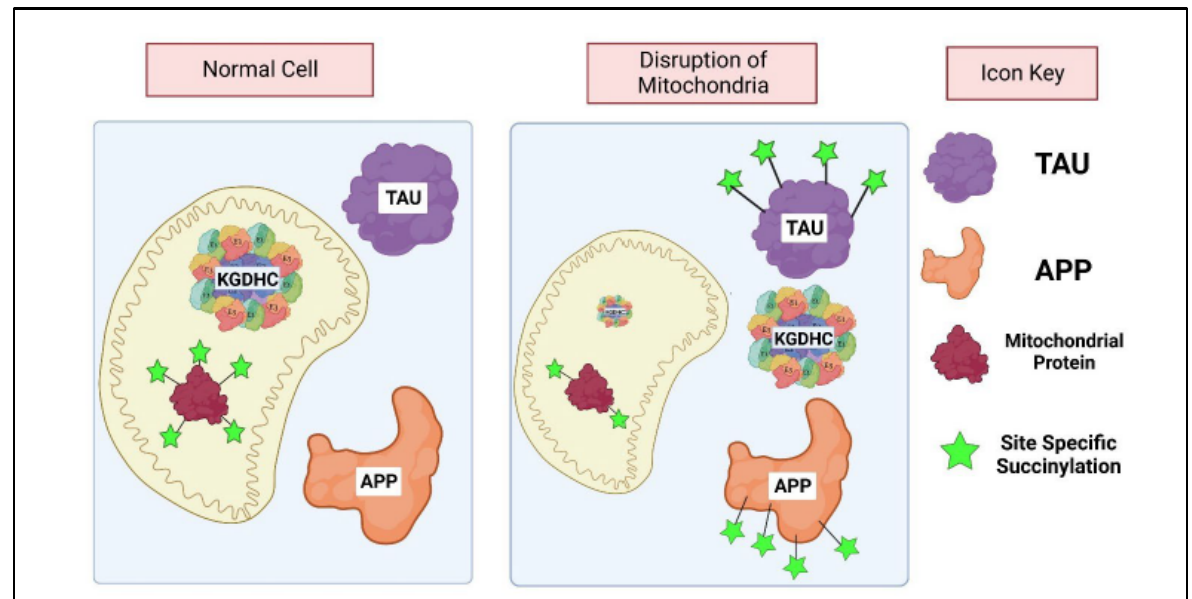
Figure 8. α -ketoglutarate dehydrogenase (KGDHC) and signaling by post translational modification through succinylation. In a normal functioning cell, KGDHC is present in the mitochondria and the E2 subunit of KGDHC is a succinyltrasferase. Mild metabolic disruption of the mitochondria causes KGDHC to leave the mitochondria and enter the cytosol where it succinylates cytosolic proteins such as amyloid precursor protein (APP) and Tau. KGDHC specifically succinylates the K612 part of APP (alpha secretase) and the K311 part of Tau (PHF 6 sequence). The succinylation of APP lead to increased amyloid β production, protein aggregation and formation of plaques. Succinylation of Tau blocks binding to microtubules, promotes aggregation and tangle formation. Both plaques and tangles play important roles in many neurological diseases, supporting the suggestion succinylation a key target for therapeutic